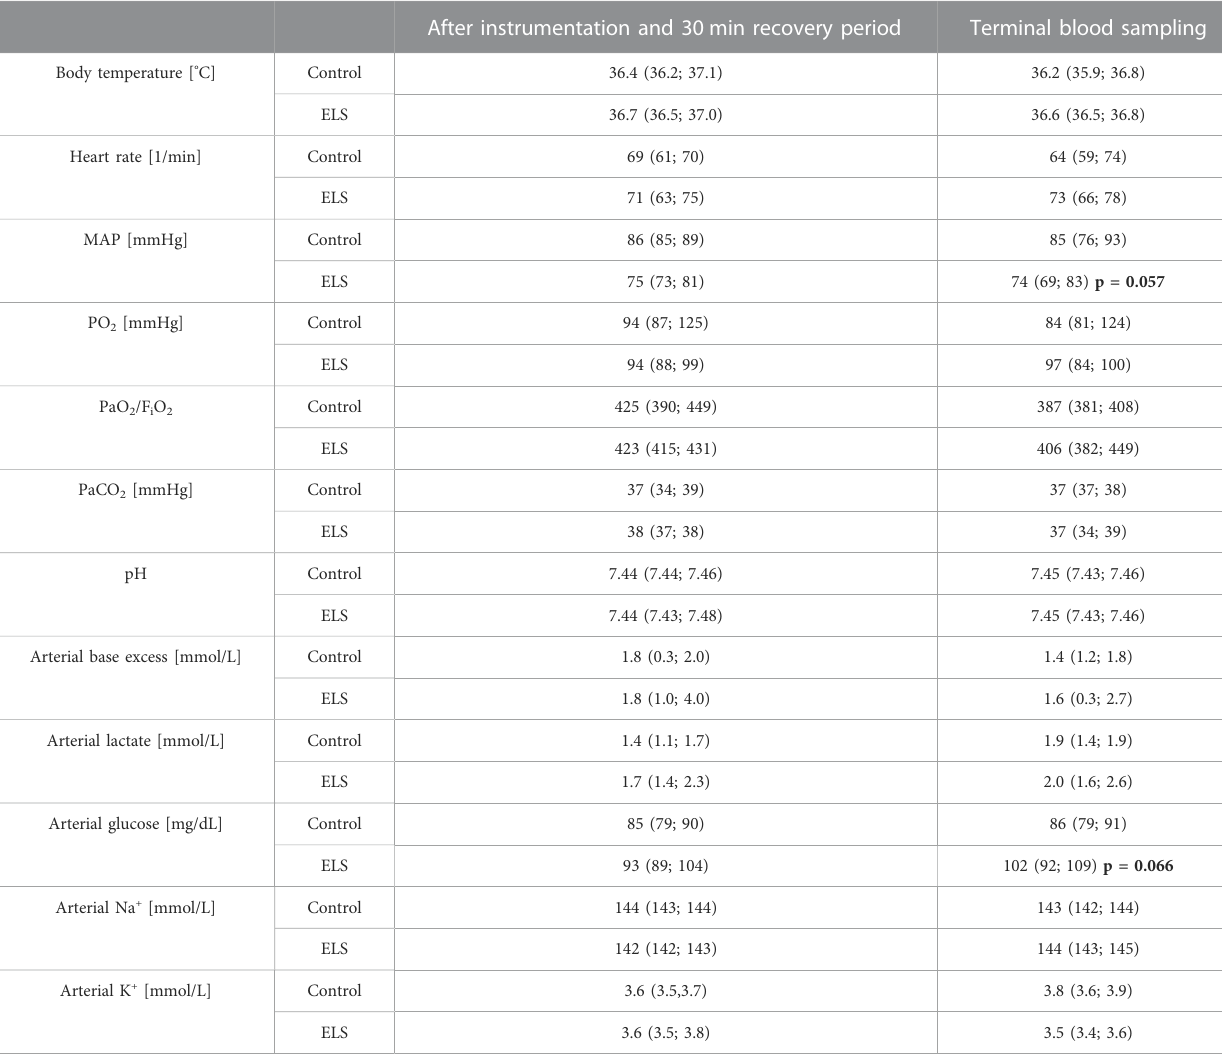
TABLE1Parametersofsystemichemodynamics,gasexchange,acid-base-status,andmetabolisminthecontrolandEarlyLifeStress(ELS)groups(n=6each).F i O 2 : inspired O 2 fraction; K + : potassium; MAP: mean arterial pressure; Na + : sodium; PaCO 2 : arterial CO 2 partial pressure; PaO 2 : arterial O 2 partial pressure; all data are median (interquartile range); bold numbers refer to p -values for intergroup comparison.